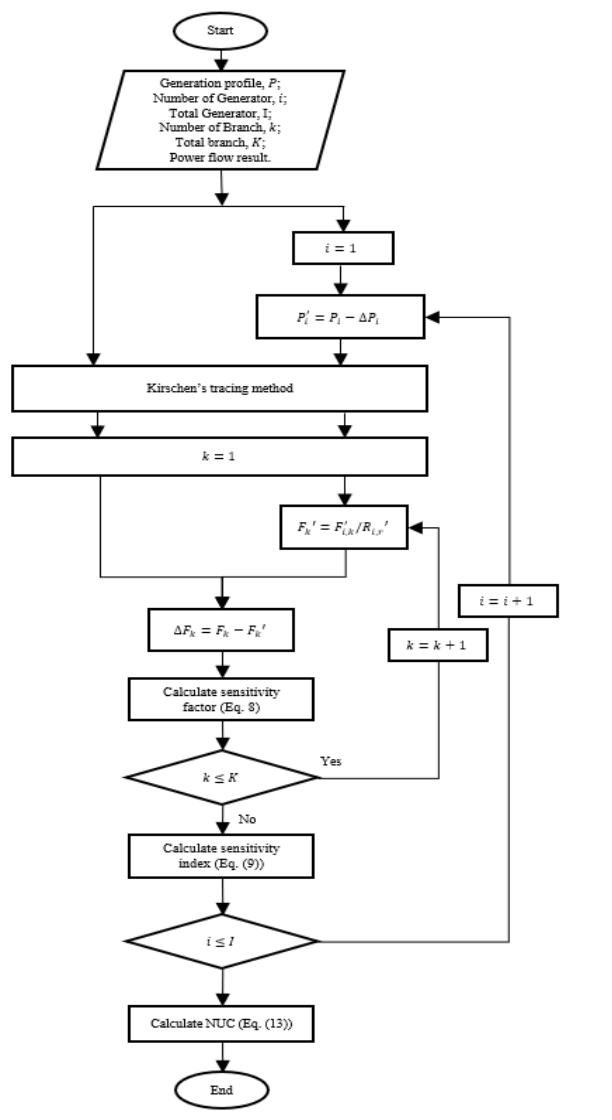
Figure 2. Proposed NCA method using a modified Kirschen’s power tracing method with sensitiv- ity index.